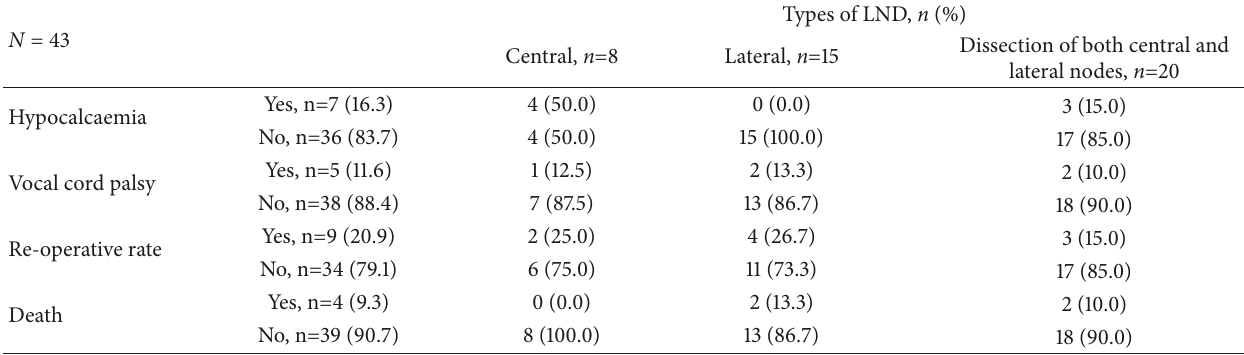
Table 4: Complications among patients that underwent lymph node